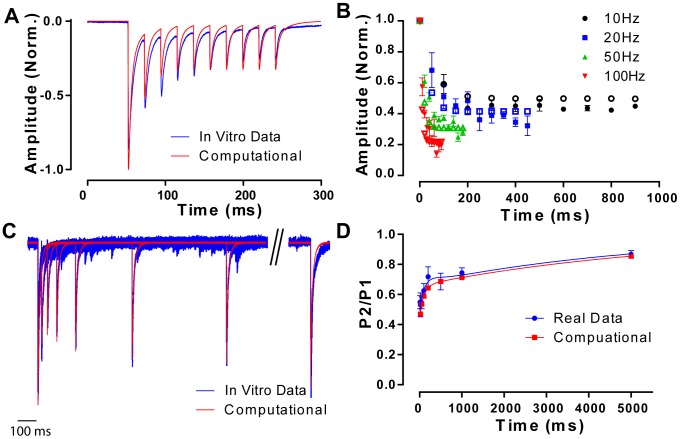
A simple model of paired pulse depression accurately modeled synaptic plasticity as seen in vitro.
A. A recorded autaptic burst at 50(blue) showing paired pulse depression (data taken from [15]). The computation model (red) is a close fit. B. Summary statistics showing paired pulse depression at autaptic connections in response to trains at several different stimulus intensities during in vitro recording (filled symbols) and during a computational model (open symbols). C. An in vitro recording of the recovery from synaptic depression (blue) fits closely with the recovery as generated by the model (red). D. Measurements of the computational model perfectly recreate the recovery from synaptic depression. Results are reported as the amplitude of the second synaptic event (P2) as divided by the amplitude of the first synaptic event (P1).